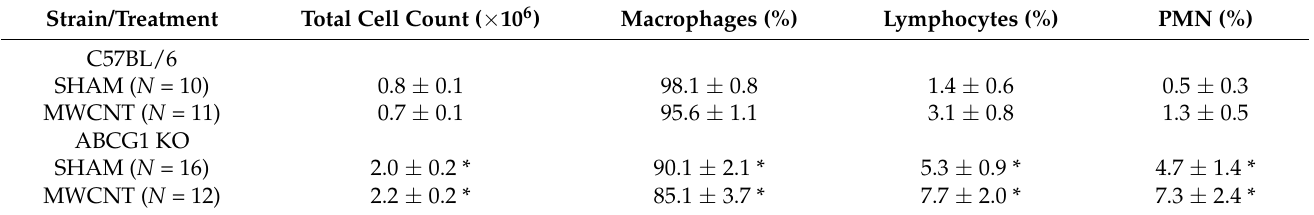
Table 1. Total and differential cell counts of BAL fluid of vehicle or MWCNT instilled animals.